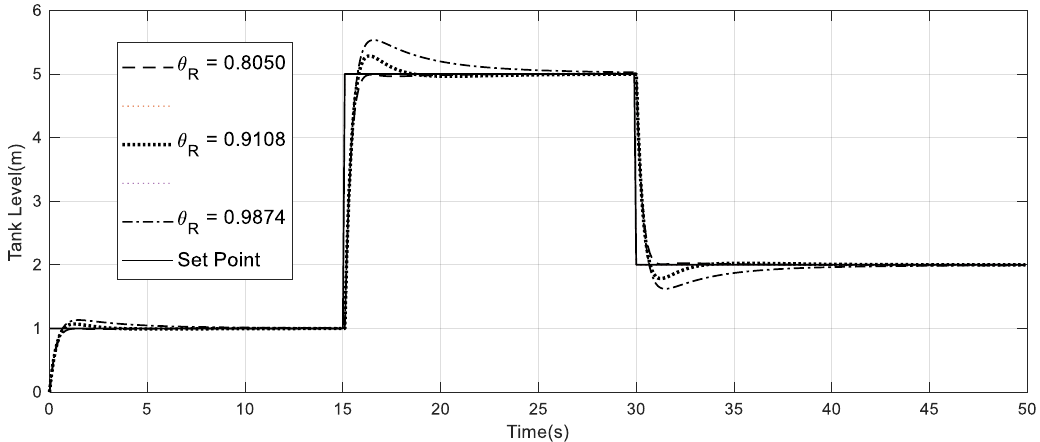
Figure 16. Response to Tool – III for changing the θ R parameter.